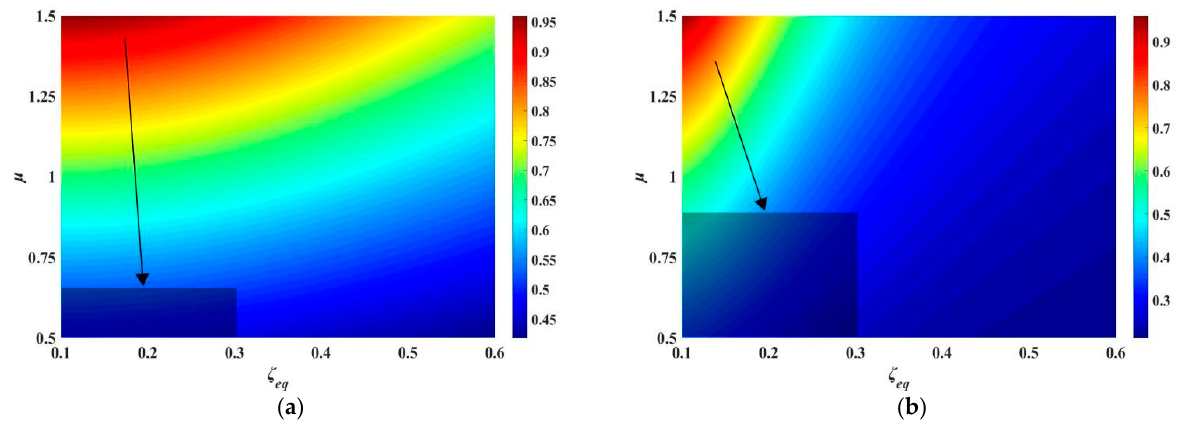
Figure 13. Contour plot of γ SF of LB–2 : ( a ) κ = 0.05; ( b ) κ = 0.1.